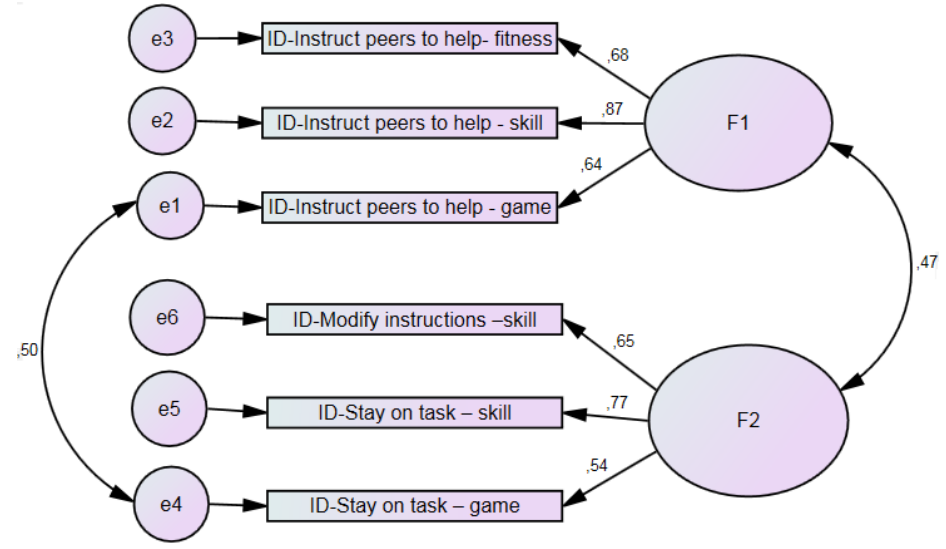
Figure 1. Path diagram of intellectual disability scale.